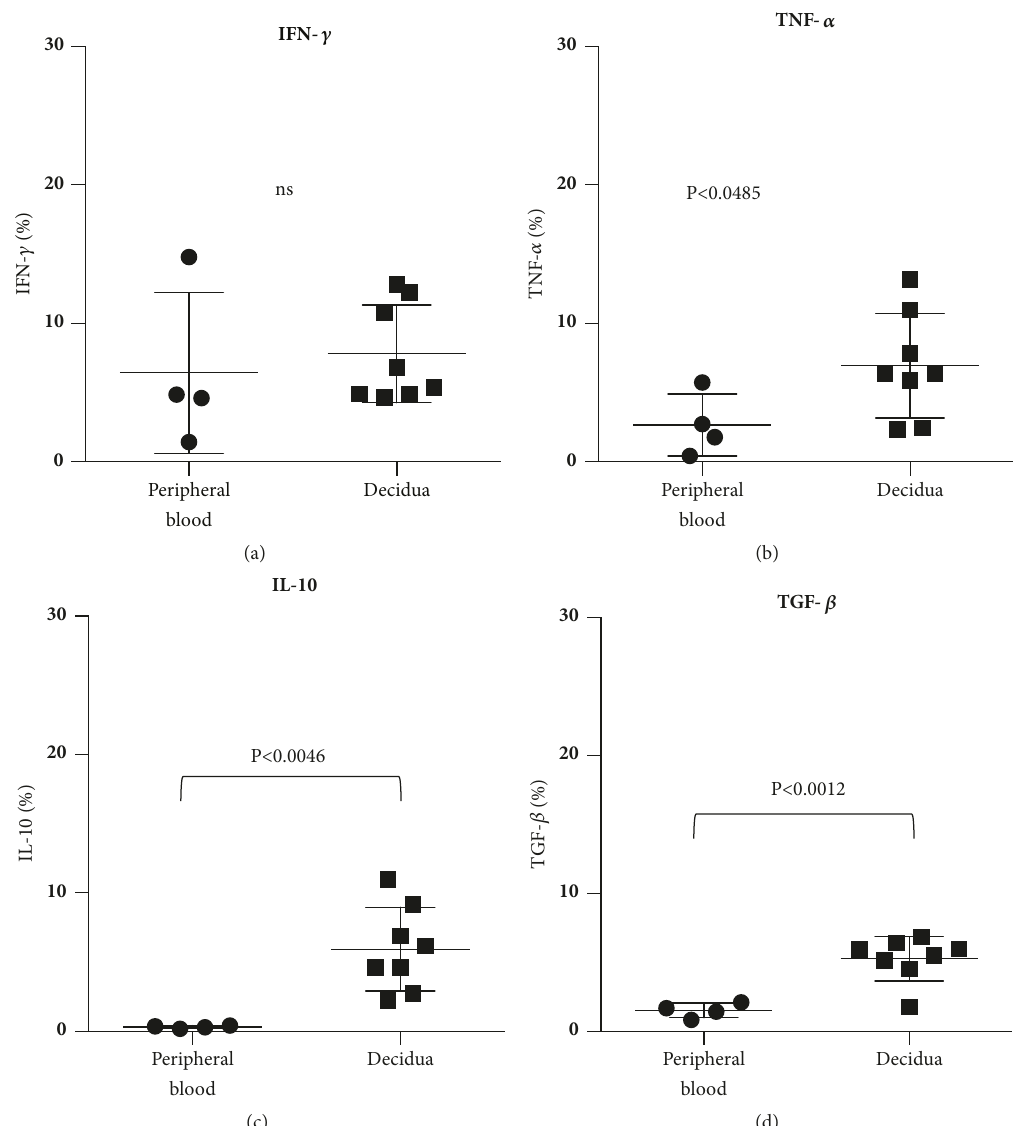
Figure 7: Production of cytokine from CD56+ cells during normal term pregnancy. (a) No significant difference was detected in the percentage of IFN- 𝛾 producing CD56+ lymphocytes between peripheral blood and decidua. (b) The percentages of TNF- 𝛼 producing CD56+ lymphocytes in decidua were higher than those in peripheral blood. (c) The percentages of IL-10 producing CD56+ lymphocytes in decidua were higher than those in peripheral blood. (d) The percentages of TGF- 𝛽 producing CD56+ lymphocytes in decidua were higher than those in peripheral